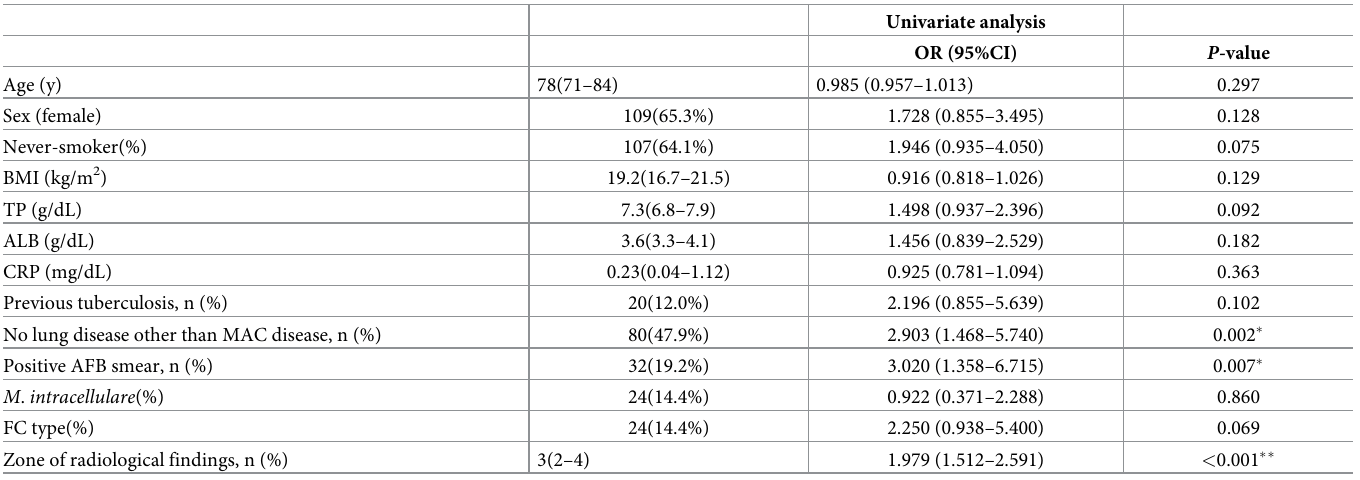
Table 2. Predictors of radiological aggravation in treatment-na ï ve pulmonary MAC subjects (n =